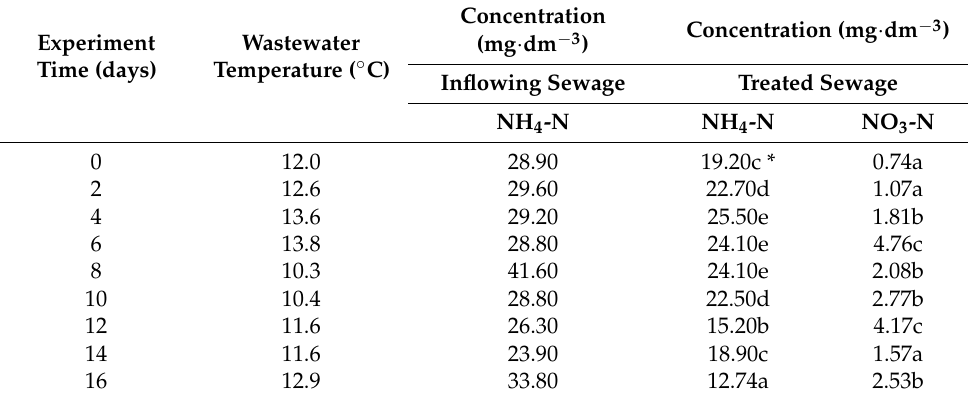
Table 8. The differences in average concentration of NH 4 -N and NO 3 -N (mg · dm − 3 ) in the biological wastewater treatment system in the control